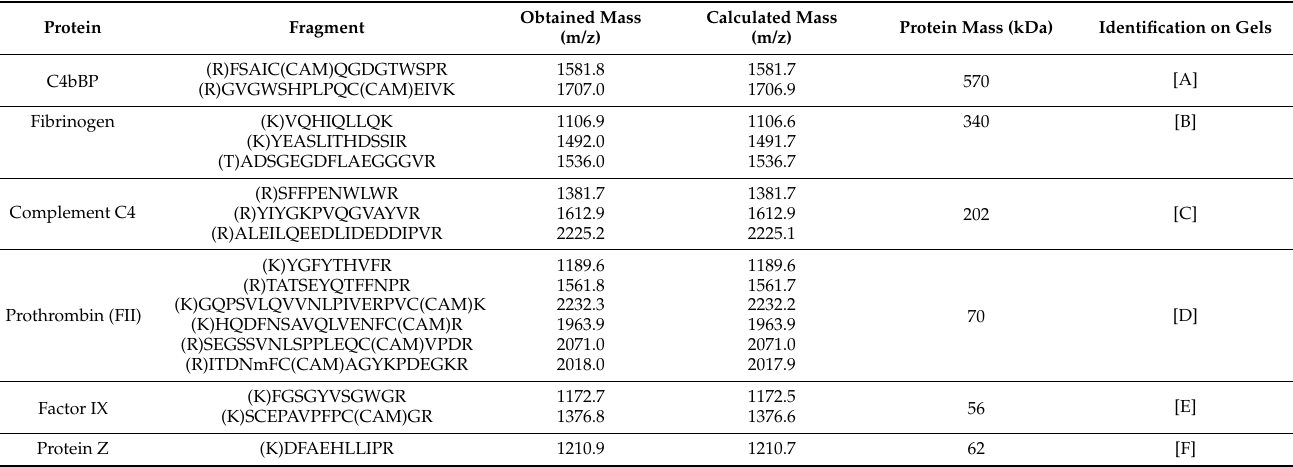
Table 4. Proteins identified by mass spectrometry of the fraction “25” from plasma purification on ANX Sepharose FF using stepwise 10 mM and 25 mM CaCl 2